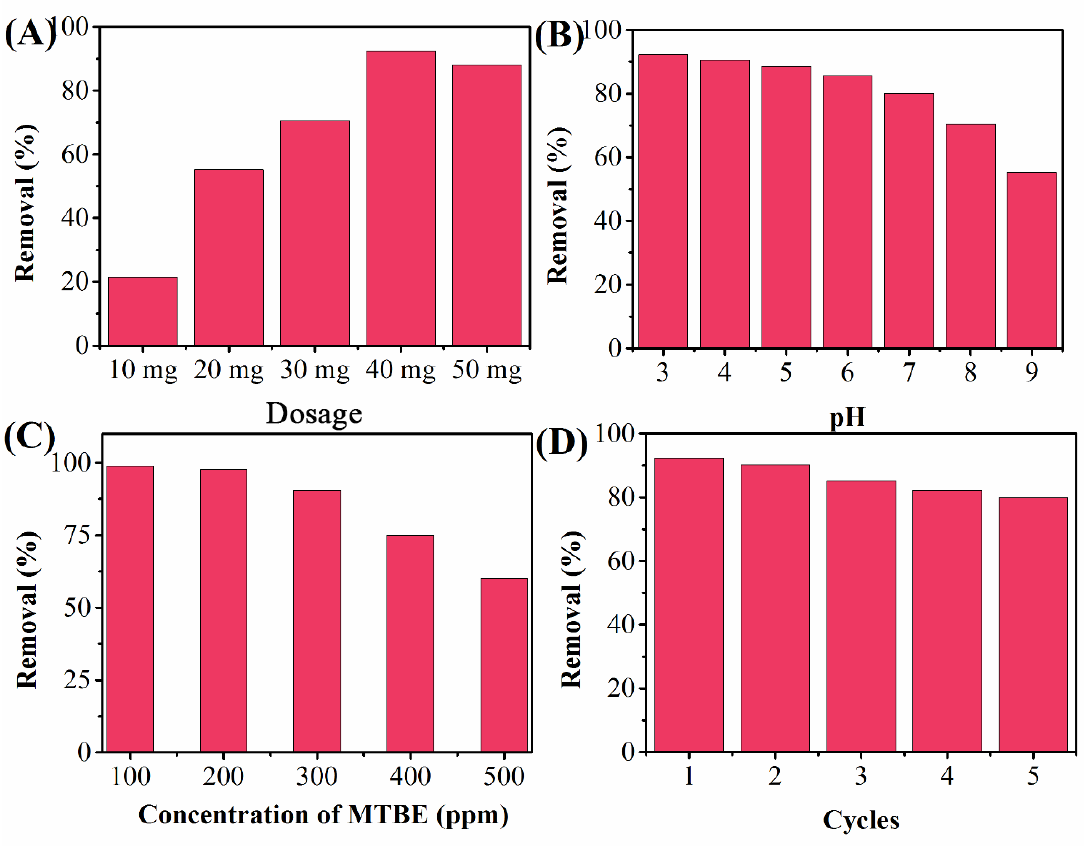
Fig. 4. (A) Effect of ZnO-AgCl-2 dosage on photodegradation efficiency of MTBE. (B) Effect of pH on photodegradation efficiency of MTBE. (C) Effect of concentration of MTBE on photodegradation efficiency of MTBE. (D) Reusability of